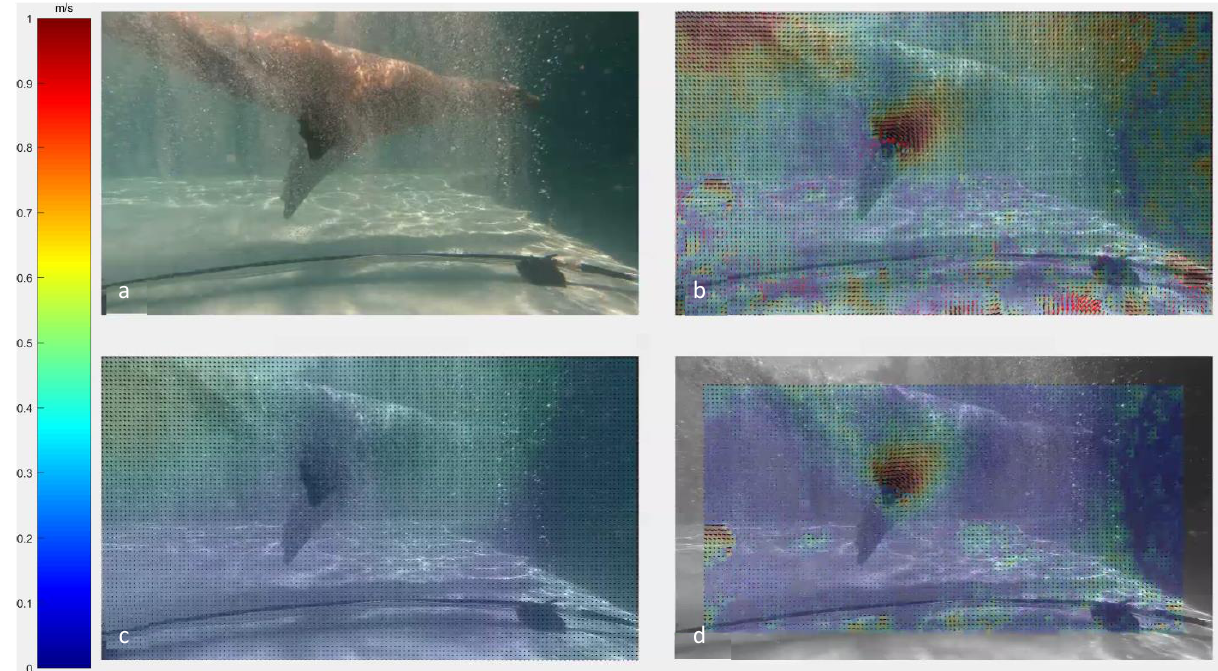
Figure 4. The buoyant rise of the bubble tracer particles must be removed from the processed data. This figure shows the raw data ( a ), the processed data without accounting for the bubble rise ( b ), the bubble velocity ( c ), and the velocity field with the bubble’s rise velocity removed ( d ). This process is detailed in Section 2.3.